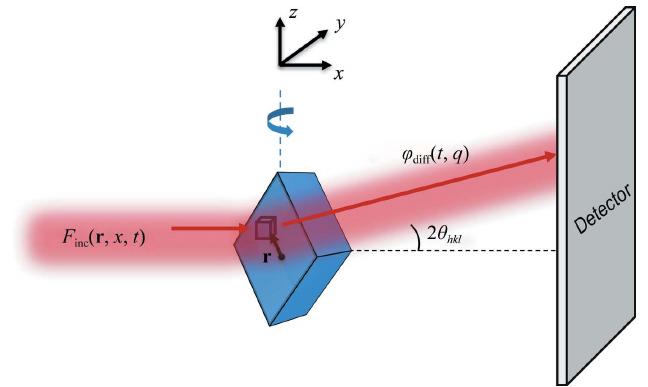
Figure 1 Experiment and simulation setup. A crystal (simulated as a rectangular prism) is located at x , y , z = 0 and a volume element (voxel) of the crystal is located at position r . The crystal is illuminated by an X-ray beam with a top-hat or Gaussian profile, and the incident photon flux at the voxel position is F inc ( r , x , t ). Crystal planes with spacing d hkl generate Bragg scattering at angle 2 (cid:3) hkl , corresponding to a scattering wavevector q hkl = 2 (cid:6) / d hkl . The scattered flux (in photons s (cid:2) 1 ) from each voxel is ’ diff ( t , q